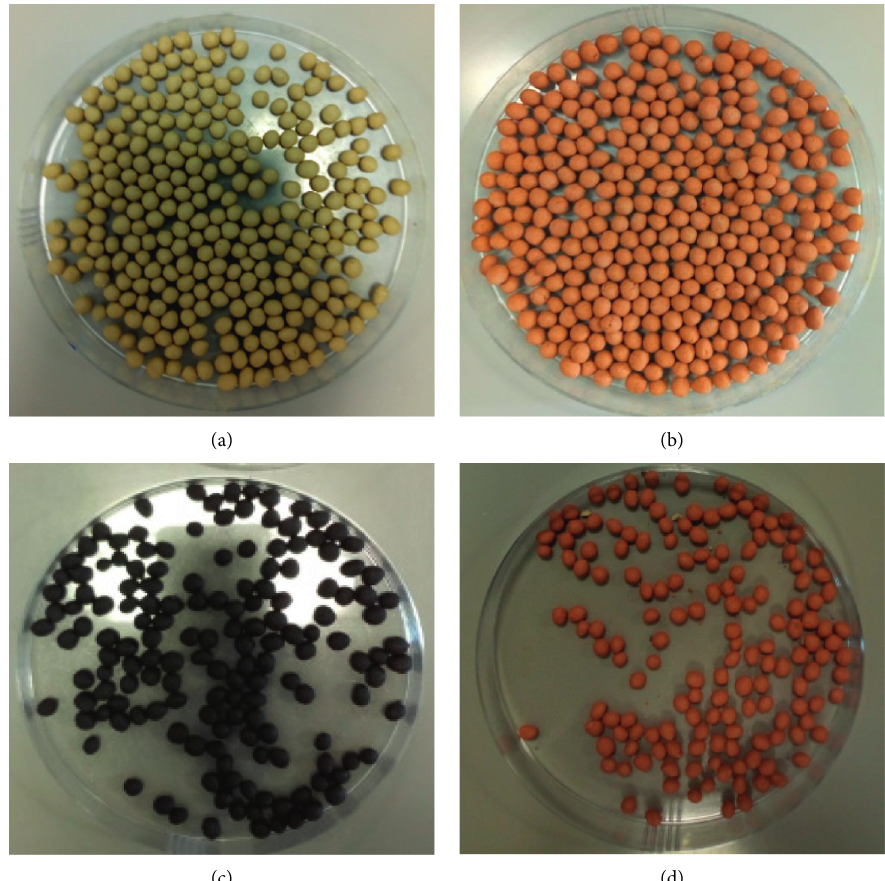
Figure 1: Adsorbents used in the adsorption experiments. (a) Green KB adsorbent. (b) Calcined KB adsorbent. (c) Green KBNPs adsorbent. (d) Calcined KBNPs